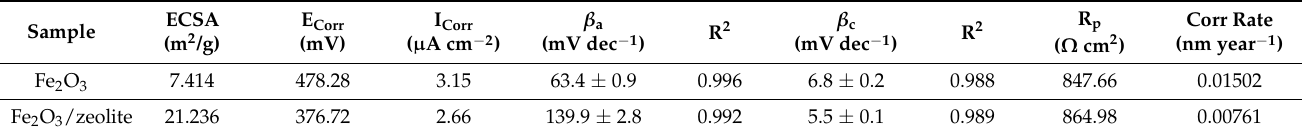
Table 3. ECSA values and corrosion and Tafel parameters for Fe 2 O 3 and Fe 2 O 3 /zeolite photocatalysts. ECSA Sample (m 2